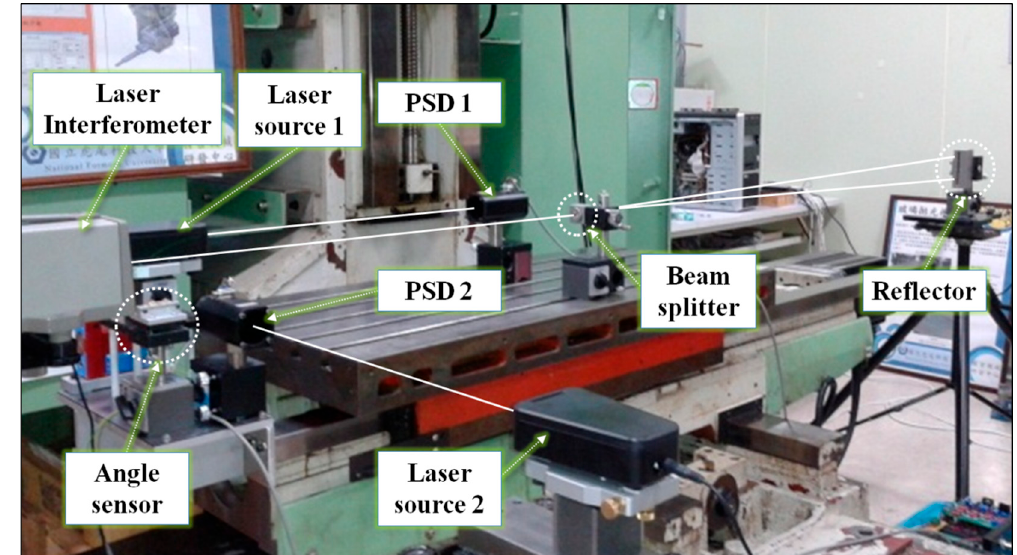
Figure 11. Verification setup of dual-axis measurements.